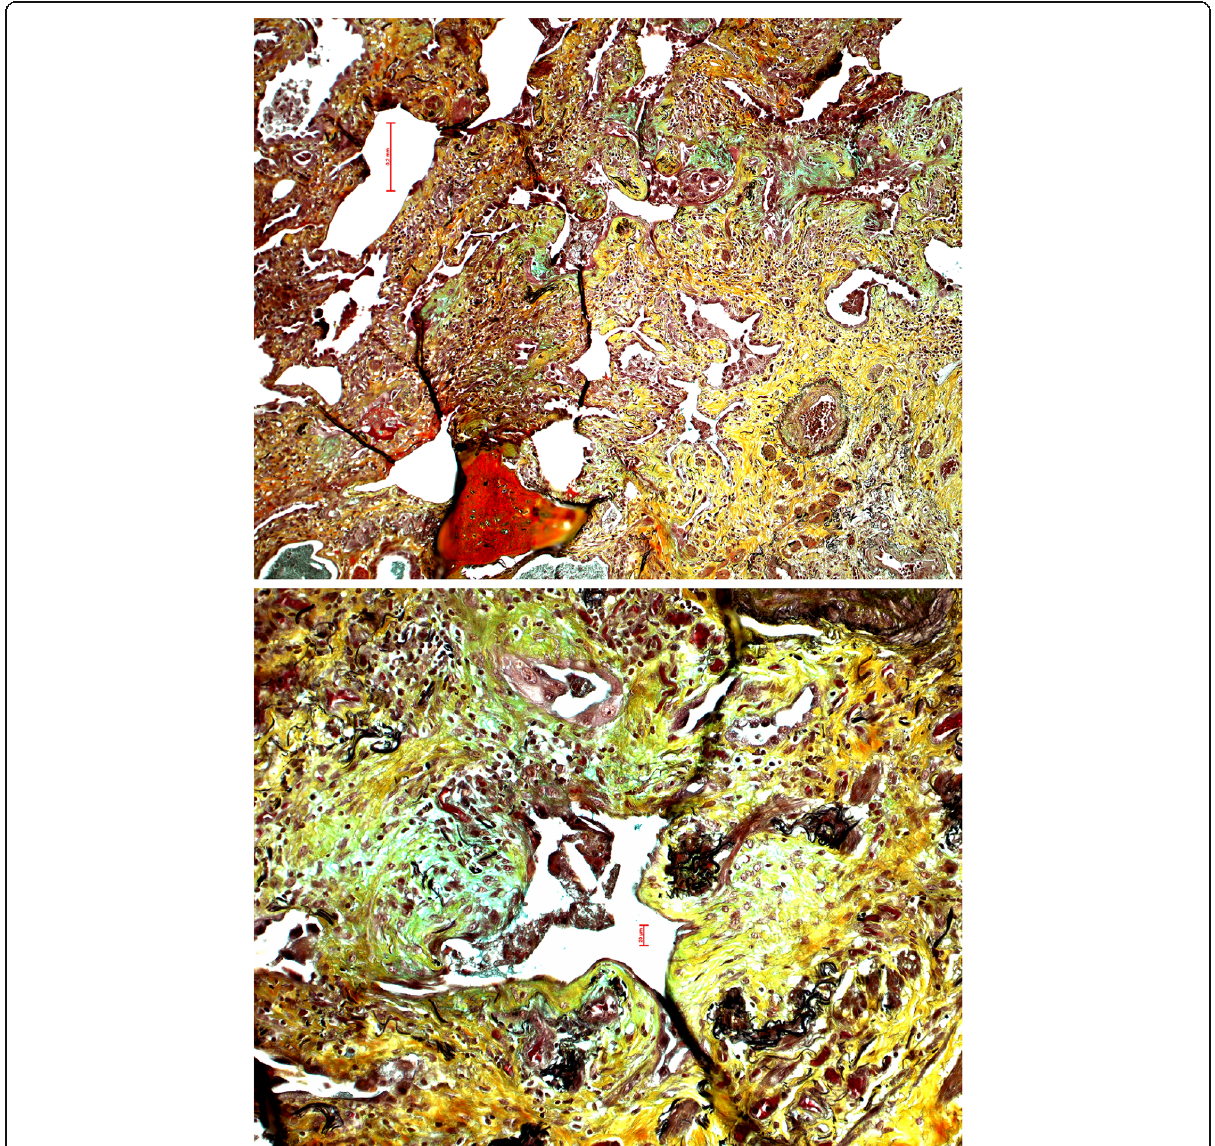
Fig. 9 Two different magnifications showing the changes of the matrix proteins in myofibroblastic foci: green for immature collagen (predominantly collagen III) and yellow mature collagen I. Movat stain, bars 200 and 20 μ